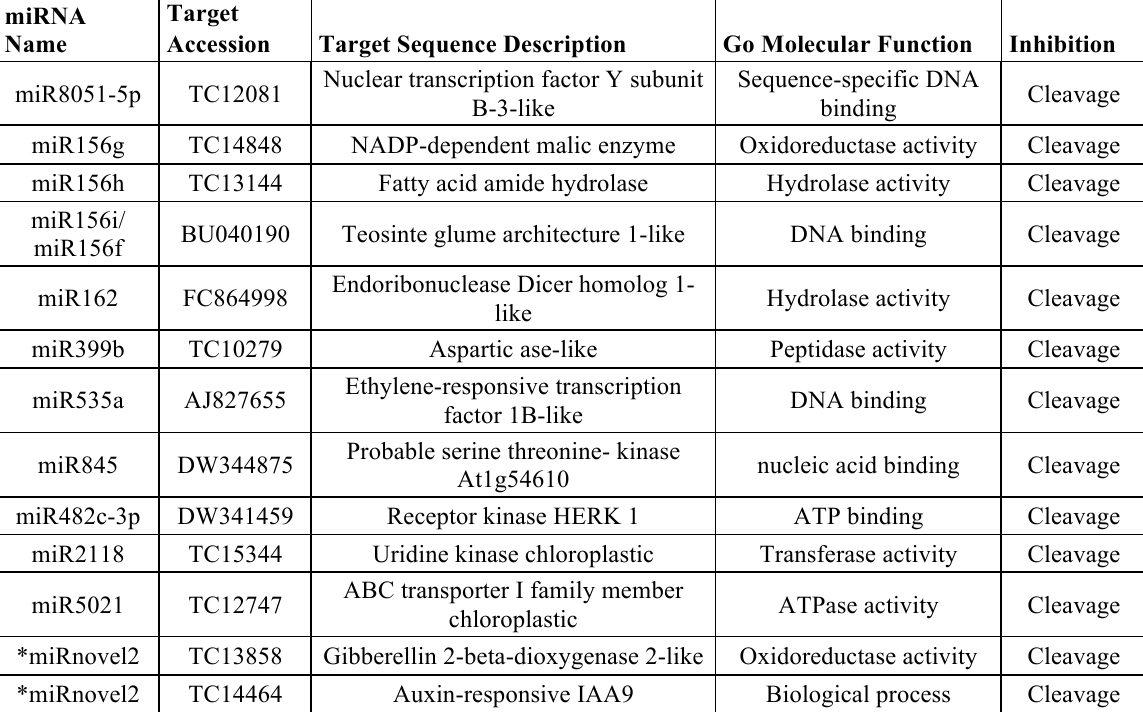
Table 3. Selected miRNA target descriptions and GO